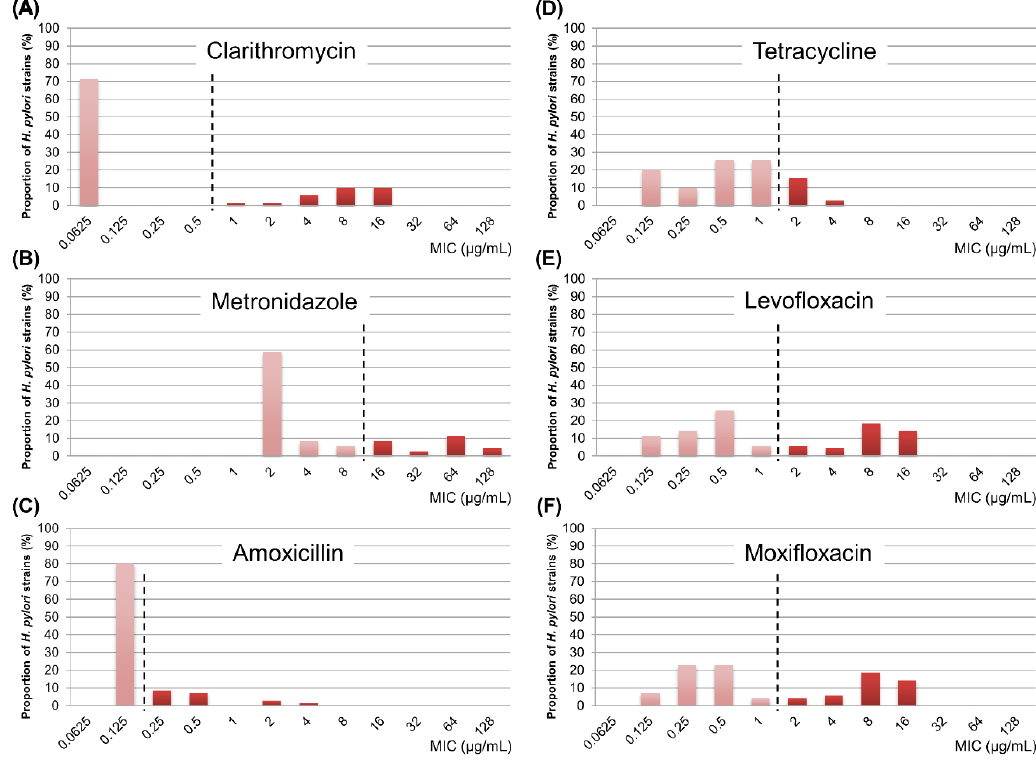
Distribution of minimum inhibitory concentration values for each antibiotic agent. ( A ) clarithromycin, ( B ) metronidazole, ( C ) amoxicillin, ( D ) tetracycline, ( E ) levofloxacin, ( F ) moxifloxacin. Vertical dashed lines indicate resistance breakpoints for each antibiotic agent. MIC, minimum inhibitory concentration.